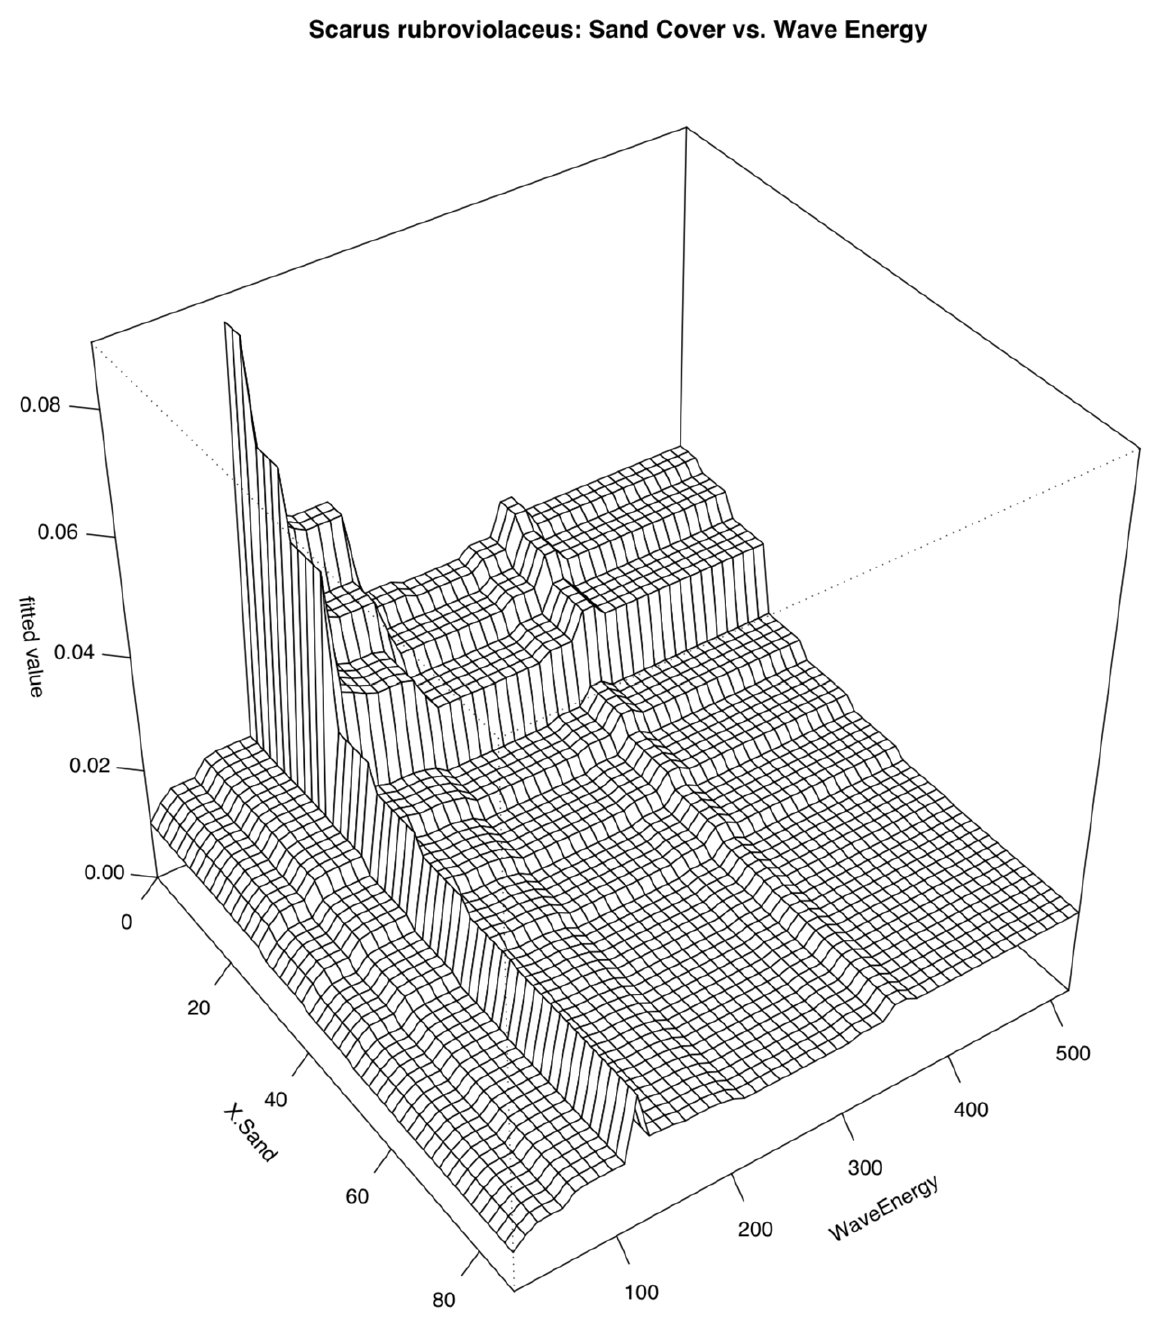
Figure 12. Pairwise interaction between wave energy and sand cover with respect to occurrence of Scarusrubroviolaceus . The effect of wave energy was highest in areas with low sand cover and the effect of sand cover was greatest in areas were wave energy was between 100 and 200 kW/m.